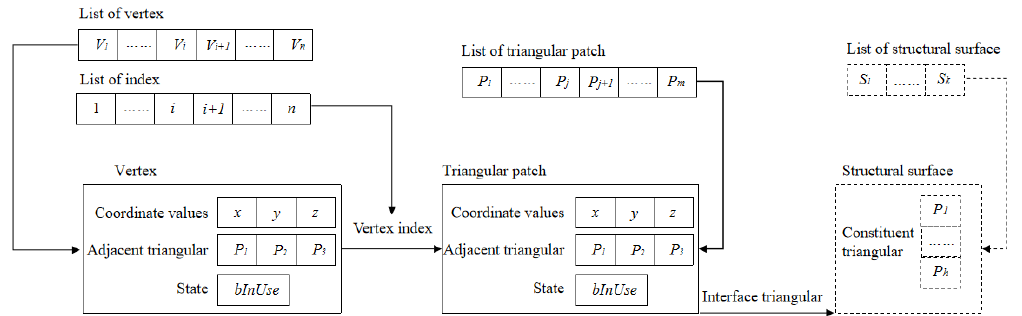
Figure 5. The continuous level-of-detail (LOD) topological data structure.